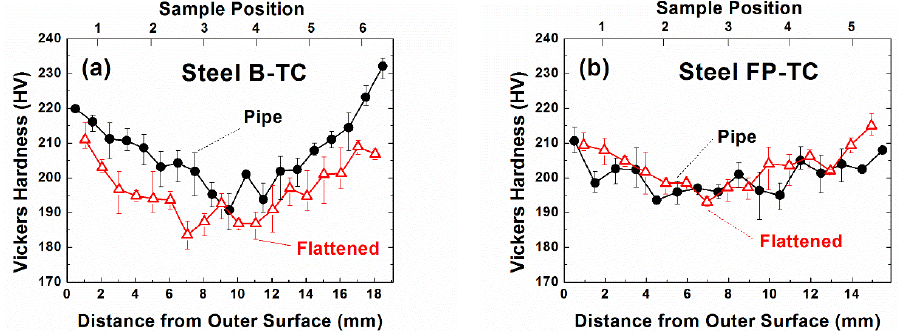
Figure 4. Vickers hardness values as a function of the distance from outer surface obtained from transverse cross-sections (TC) of both as-received pipes and its flattened state: ( a ) steel B and ( b ) steel FP.